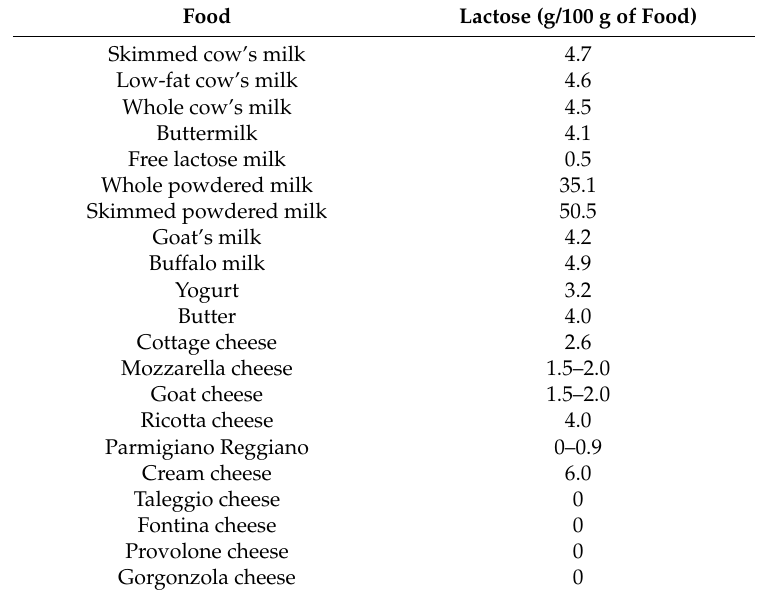
Table 3. Lactose content in common dairy foods.